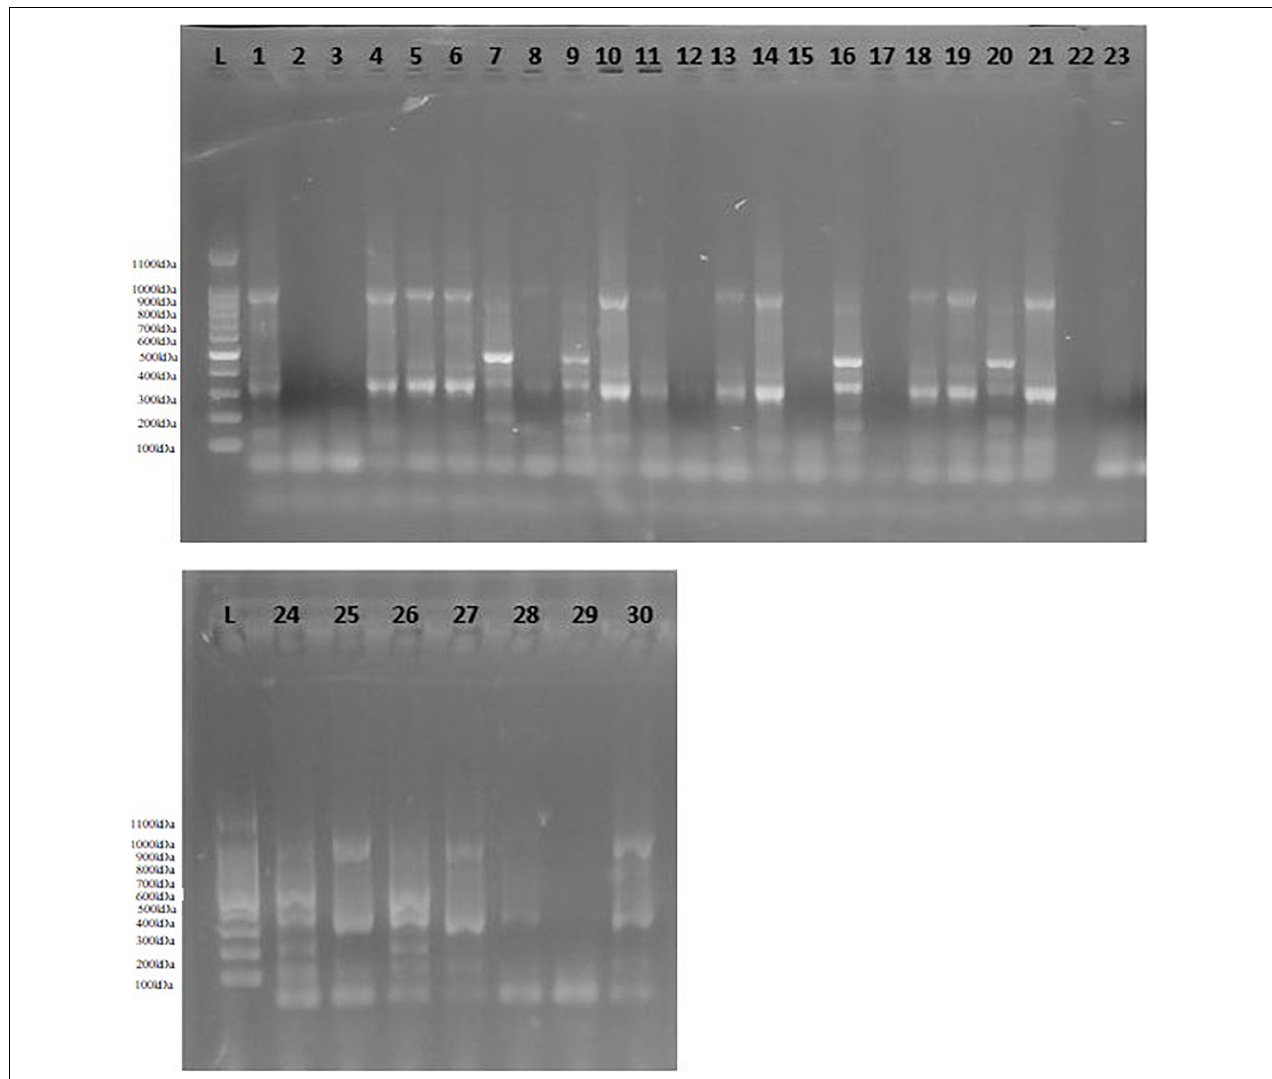
FIGURE 3 | Allelic profile of oxalate-CoA ligase among spinach accessions generated by primer pair OxLig-1. L = 100 bp ladder, 1 = 321,021, 2 = 19,339, 3 = 30802, 4 = 18,649, 5 = 18,654, 6 = 30,518, 7 = 32,618, 8 = 227,230, 9 = 379,549, 10 = 18,650, 11 = 32,122, 12 = 508,504, 13 = 647,858, 14 = 604,785, 15 = 163,309, 16 = 163,310, 17 = 419218, 18 = 212,119, 19 = 647853, 20 = 30,526, 21 = 18,655, 22 = 266,926, 23 = 261,789, 24 = 181,964, 25 = 179,593, 26 = 227,383, 27 = 648,942, 28 = 648,944, 29 = 184,379, 30 =